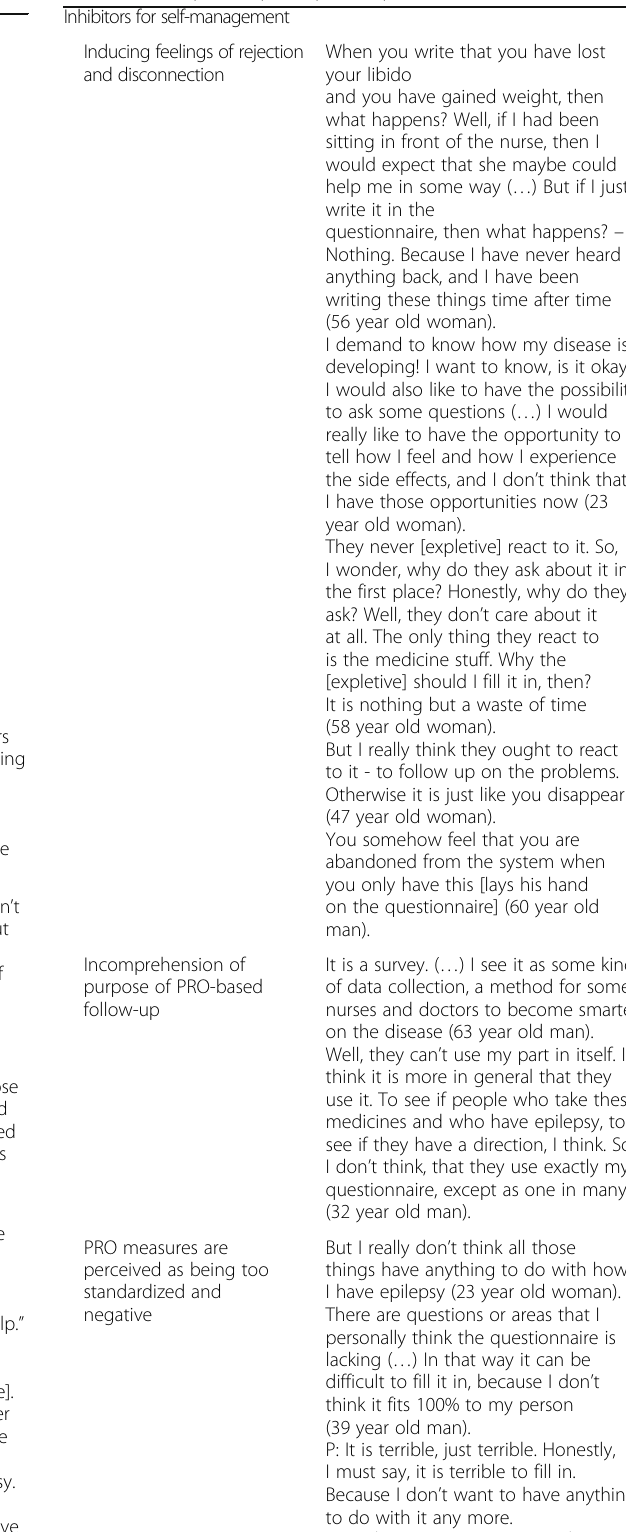
Table 2 Examples of participants ’ quotes